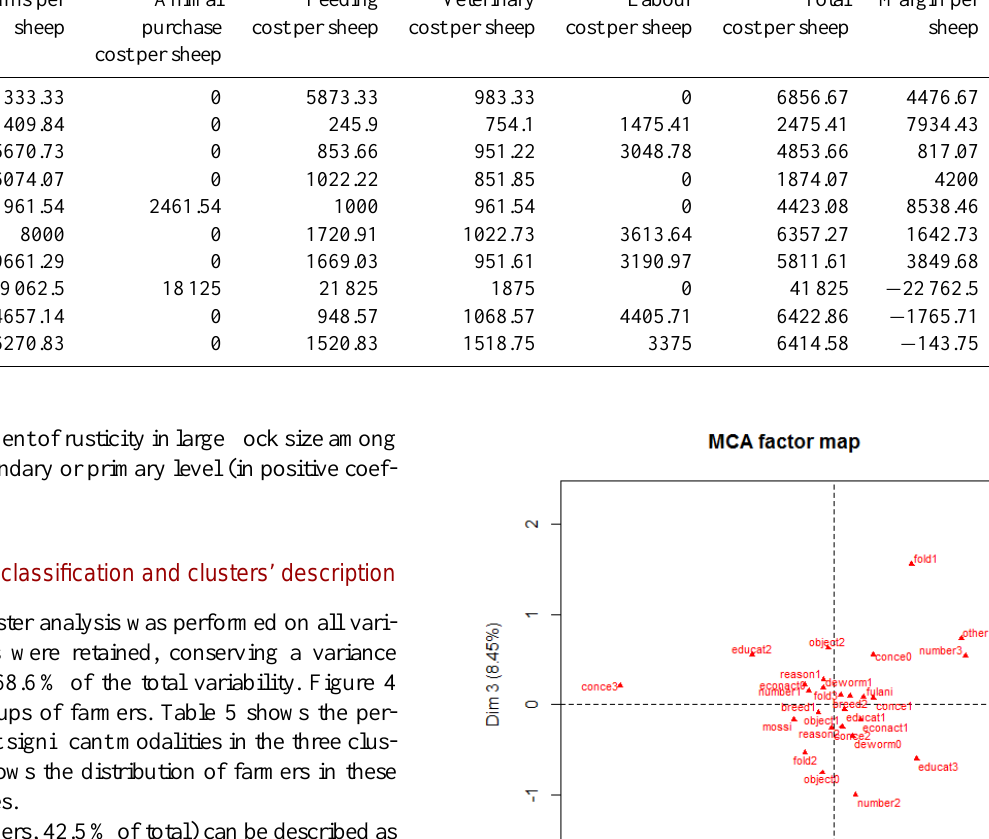
Table 3. Costs, returns, and margin in FCFA for 10 breeders. Farm Returns per Animal Feeding Veterinary Labour Total Margin per number sheep purchase cost per sheep cost per sheep cost per sheep cost per sheep sheep cost per sheep